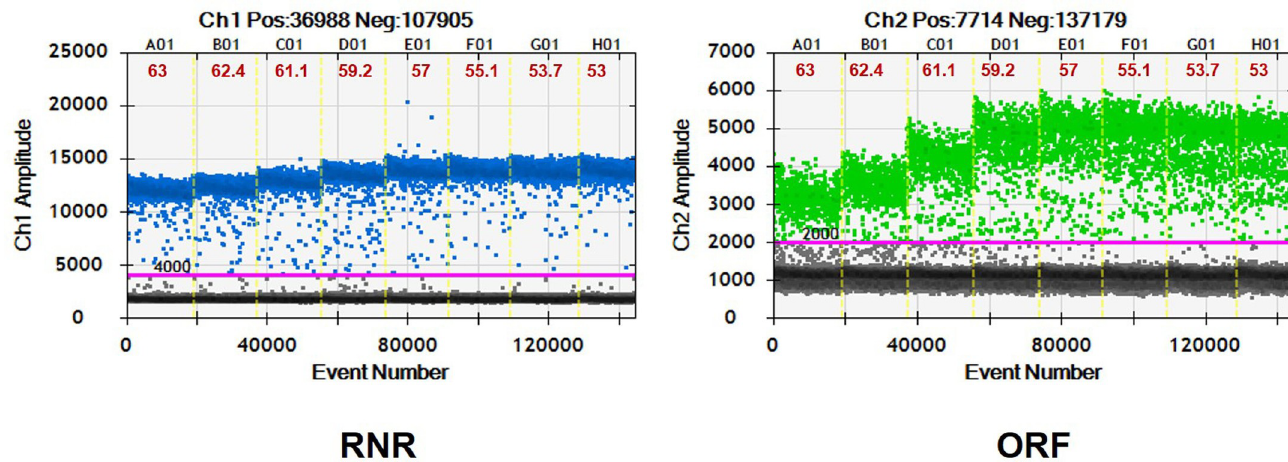
Fig 4. Thermal gradient droplet digital PCR for optimizing annealing temperature. (A) RNR of “ Candidatus Liberibacter asiaticus”; (B) ORF1 of Spiroplasma citri . Eight ddPCR reactions with an annealing temperature gradient ranging from 53˚C to 63˚C are divided by vertical dotted yellow lines. The pink line is the threshold, above which are positive droplets (blue/Green) and below are negative droplets (gray) without any target DNA.